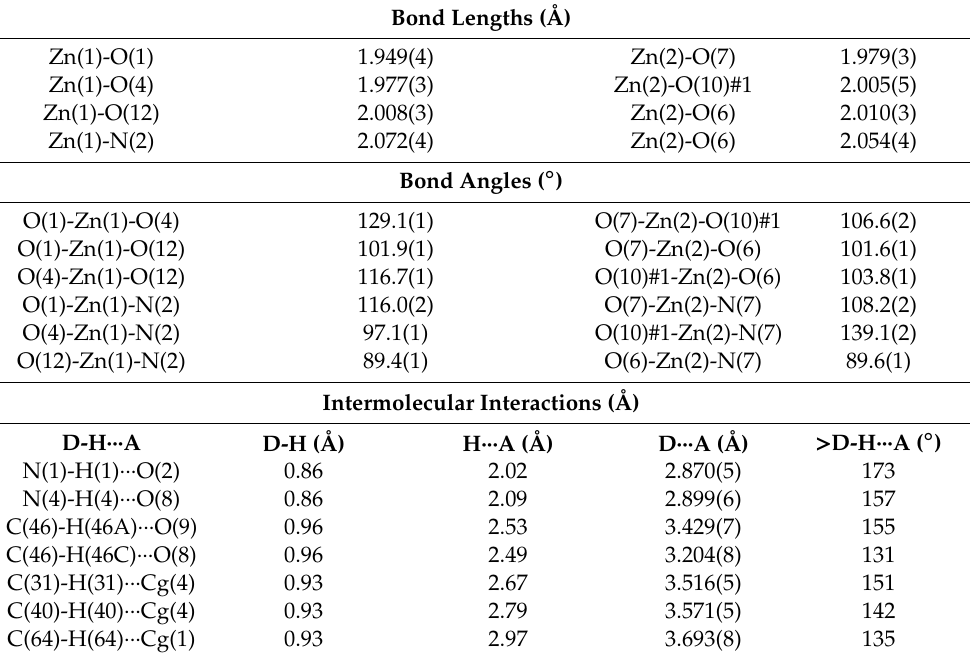
Table 1. Selected bond lengths (Å), bond angles (°), and intermolecular interactions (Å) of compound 1 .